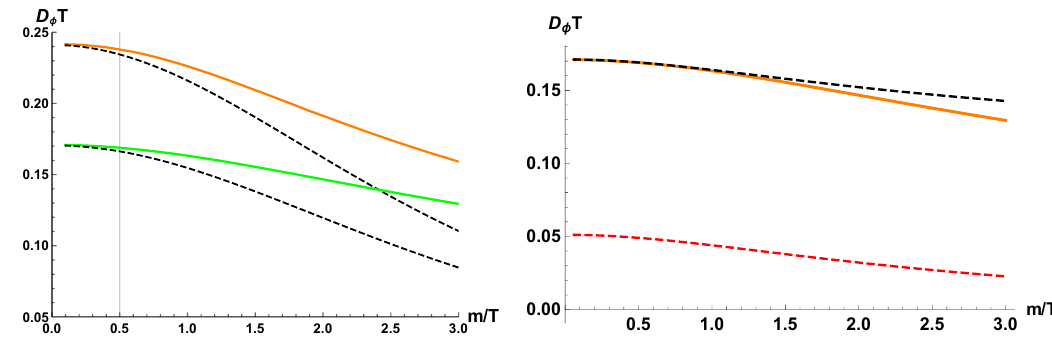
Figure 10 . Left: the comparison between the numerical data for the di(cid:11)usion constant D (cid:8) (solid lines) and the holographic formula (3.28) (dashed lines). The di(cid:11)erent cases are for N = 3 (upper, solid line) and N = 5 (lower, solid line). Right: the comparison between the numerical value of the di(cid:11)usion constant D (cid:8) for N = 5 (solid line) and the predictions given by the hydrodynamic formula (3.23) (lower, dashed line). The upper dashed black line is the formula (3.23) with an additional constant shift. The agreement between the shifted hydrodynamic formula and the data is evident and valid until quite large values of m=T